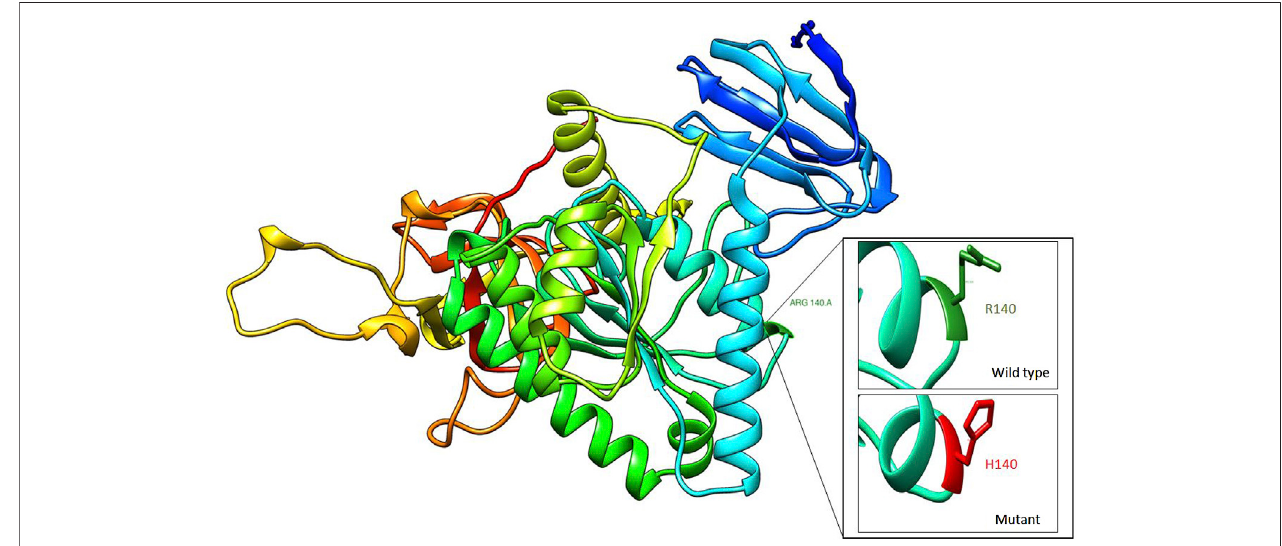
FIGURE 2 | Homology modeling of CLP1 protein showing structural differences between wild type (R140) and mutant residue (H140).